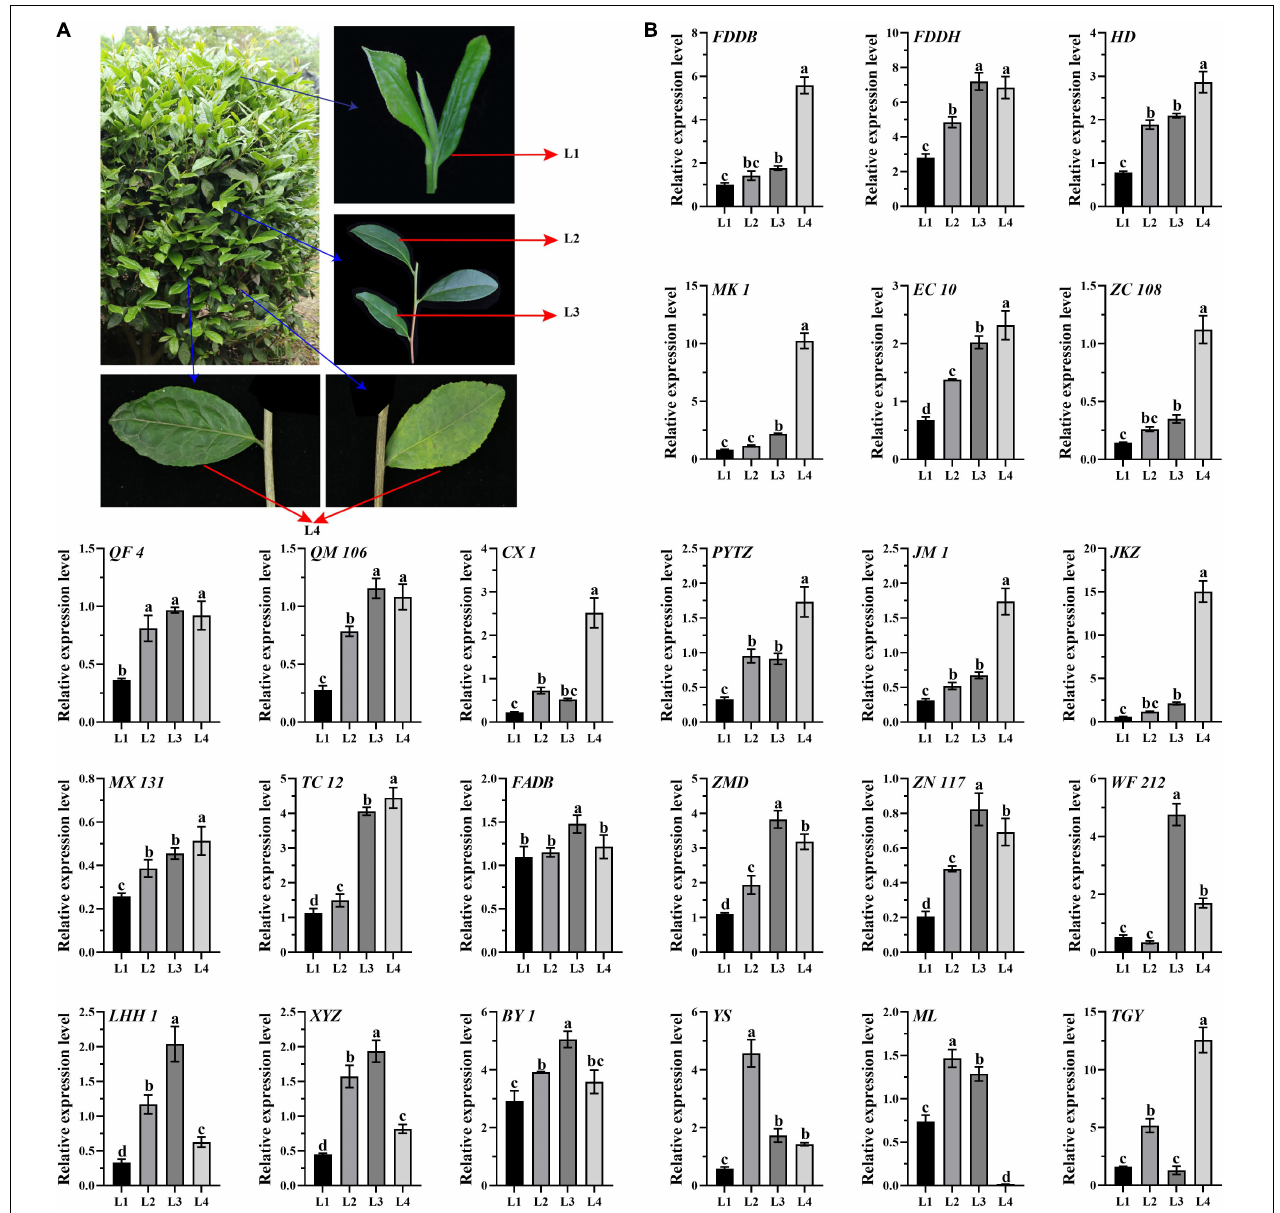
FIGURE 1 | Expression analysis of CsATG101 in the four categories of leaves of 24 tea cultivars. (A) Representative tea plant branches for sampling. L1, one bud with two developing leaves; L2, the recently developed leaves attached to the green stems L3, the mature leaves attached to the red stem; L2 and L3 developed in the same year as L1; and L4, aged leaves developed last year. (B) Expression patterns of CsATG101 in the four categories of leaves of 24 tea cultivars. CsGAPDH was used as the internal control, and the sample of L1 for FDDB was the control sample. Three technical replicates were performed. Data are means ± SD . Significant differences are indicated by letters (ANOVA; P ≤